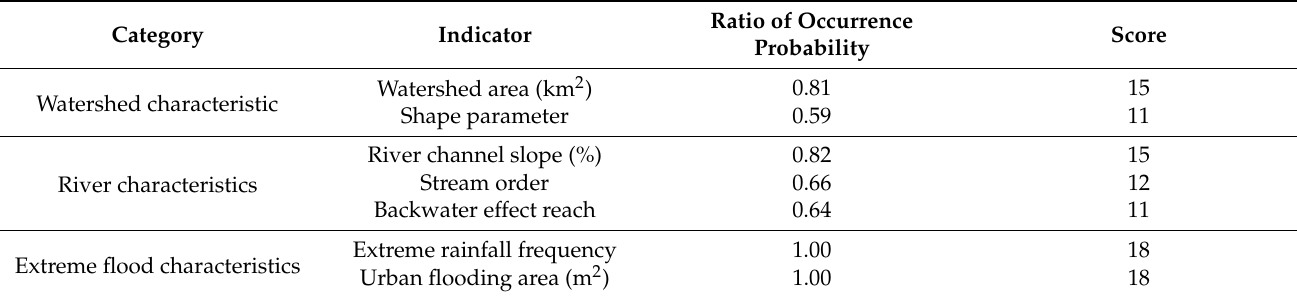
Table 2. Ratio of occurrence probability and scores for indicators.